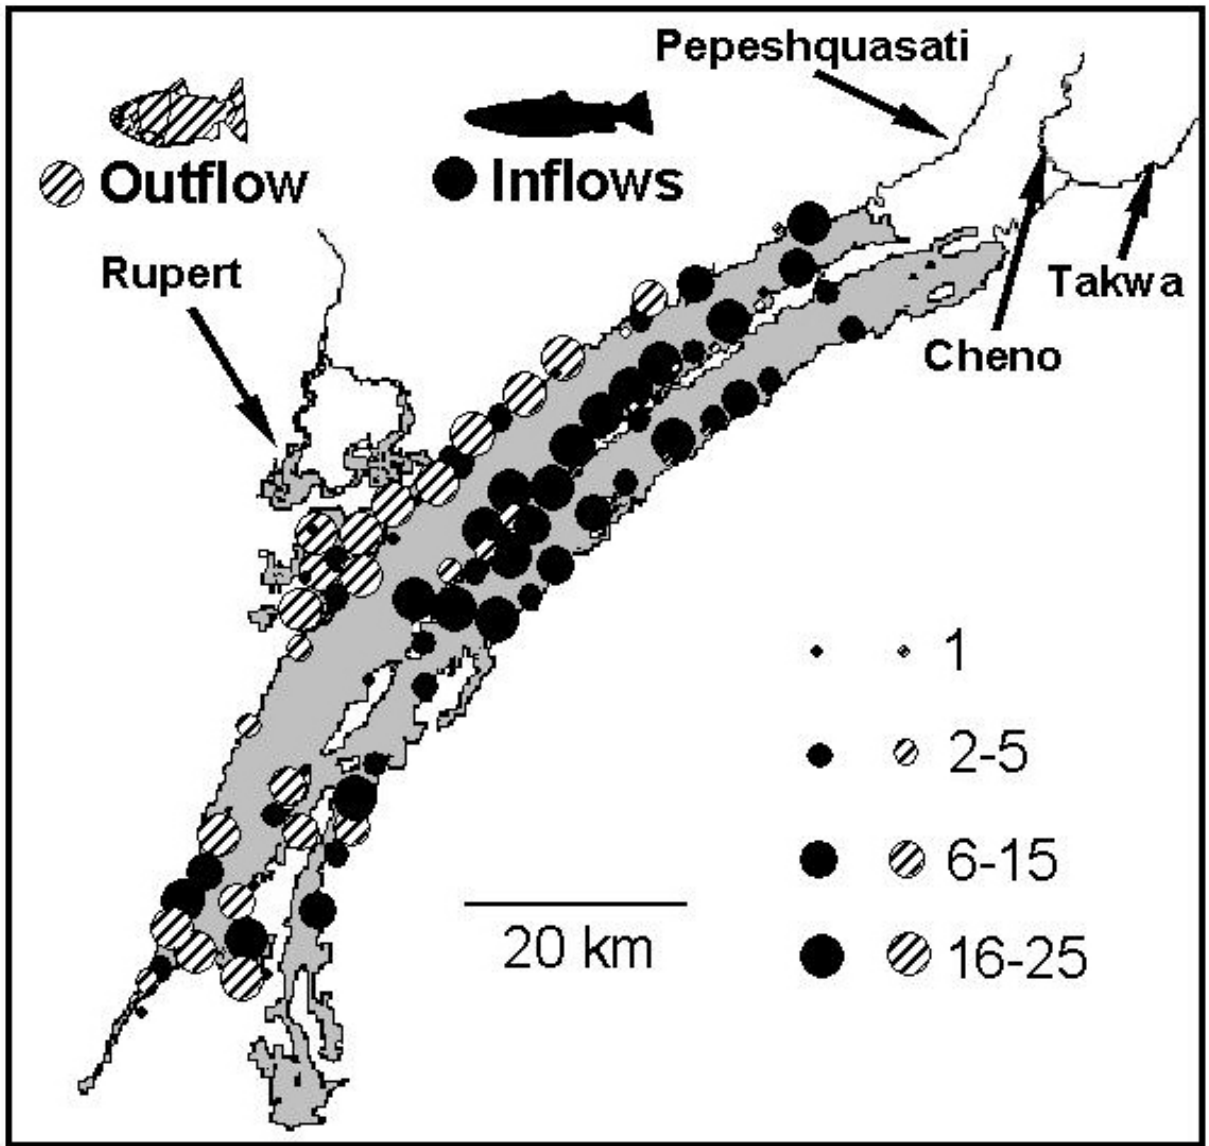
Fig. 2. Summer spatial distributions of outflow for the Rupert and inflow for the Pepeshquasati, Cheno, and Takwa populations of brook charr ( Salvelinus fontinalis ) in Mistassini Lake, according to scientific data from Fraser and Bernatchez (2005 a ). Genetic markers were used to assign individuals captured throughout the lake to their respective population of origin (details of methodology in Fraser and Bernatchez 2005 a ). Inflow populations are denoted in black because their spatial distributions did not differ from one another; the spatial distribution depicted is for the year 2001, but similar results were obtained for year 2000 (Fraser and Bernatchez 2005 a ). The size of the circles within the legend is proportional to the number of individuals assigned to populations at each sampling